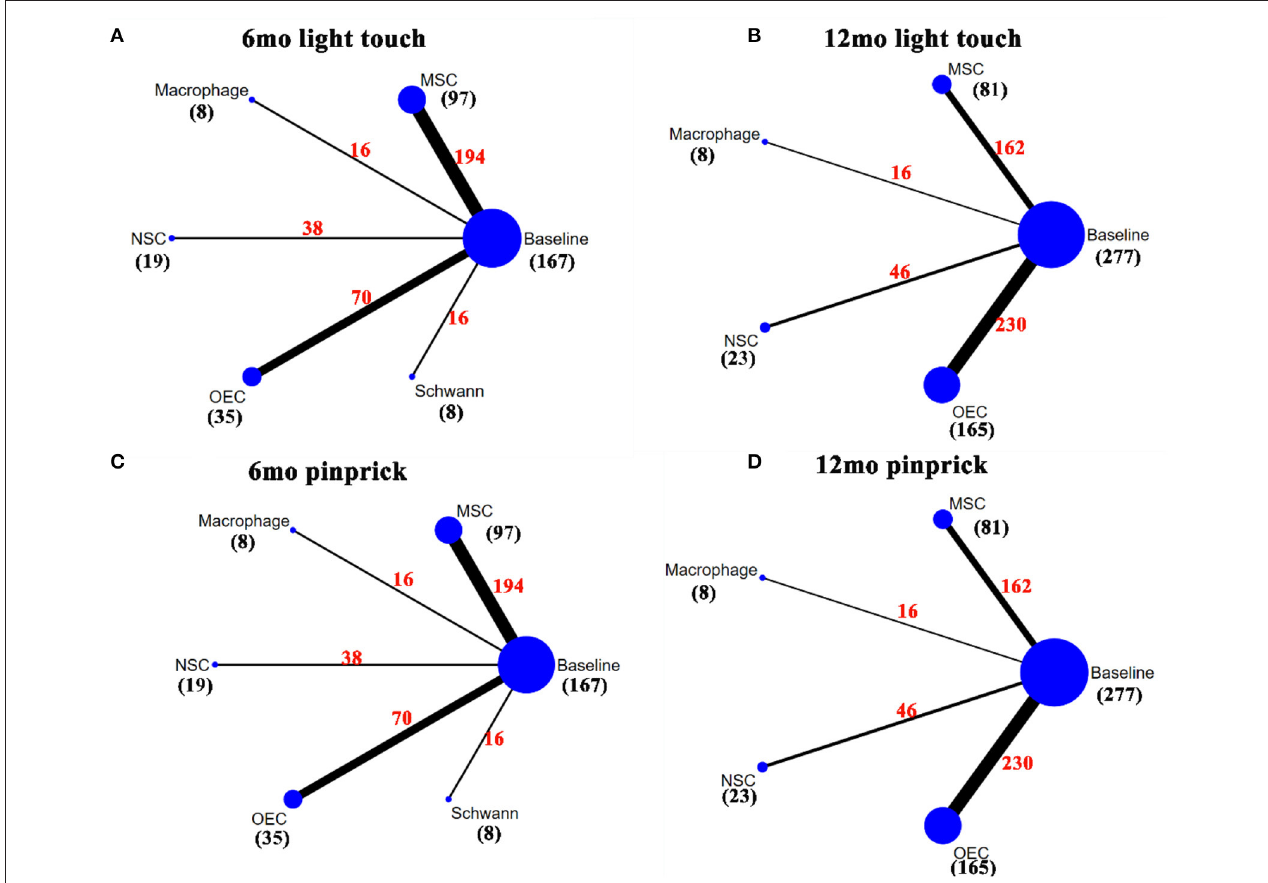
FIGURE 3 | Network plot for light touch and pinprick. (A) A network plot for 6mo ASIA light touch score; (B) A network plot for 12mo ASIA light touch score; (C) A network plot for 6mo ASIA pinprick score; (D) A network plot for 12mo ASIA pinprick score. The nodes represent different interventions, the size of the nodes represents the sample size of that intervention, and the thickness of the lines connecting the nodes represents the sample size involving both interventions. The black number represents the sample size of the intervention, and the red number represents the total sample size of the two connected interventions. ASIA, American Spinal Cord Injury Association; mo, month; MSC, mesenchymal stem cell; NSC, neural stem cell/neural progenitor cell; OEC, olfactory ensheathing